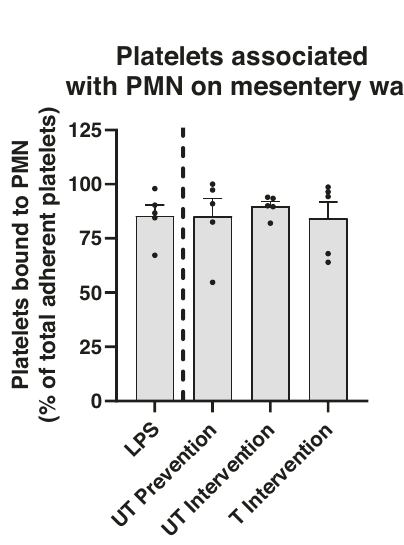
Fig. 6 | Polystyrene (PS) particle treatment does not alter phenotype of neu- trophils in in fl amed mouse mesentery. a The percent of total platelets adherent tomesenterythatareassociatedwithaboundneutrophil(PMN)(oftotalnumberof platelets bound to vascular wall). b The average number of platelets adherent to each adherent neutrophil in the mesentery. Experimental groups consist of N =5 mice per group with 2 – 4 independent vessels imaged per mouse. ‘ LPS ’ refers to